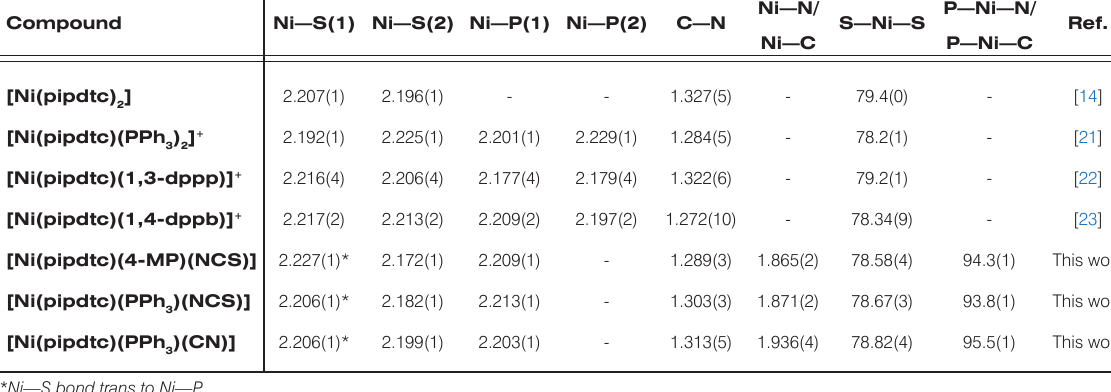
Figure 5. ORTEP of [Ni(pipdtc)(PPh Table 3. Comparison of bond distances (Å) and angles (°). Compound